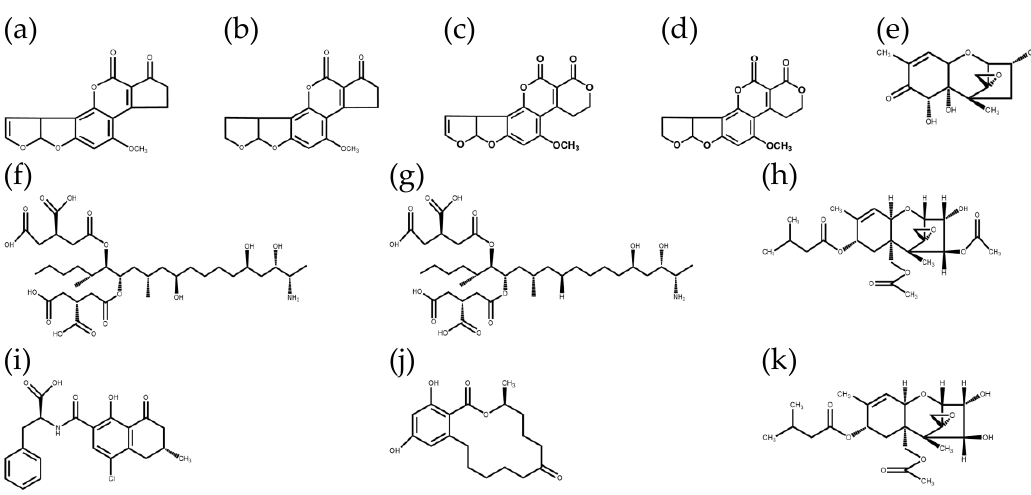
Figure 1. Chemical structures of the 11 mycotoxins: (a) aflatoxin B1; (b) aflatoxin B2; (c) aflatoxin G1; (d) aflatoxin G2; (e) deoxynivalenol; (f) fumonisin B1; (g) fumonisin B2; (h) T-2 toxin; (i) ochratoxin A; (j) zearalenone; (k) HT-2 toxin.